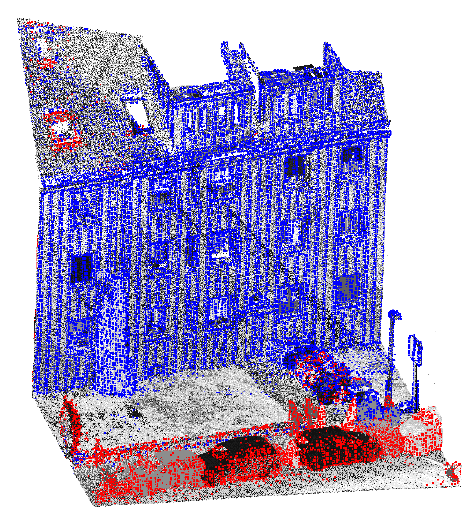
Figure 10. Point cloud after change detection; blue: permanently occupied, red: temporarily